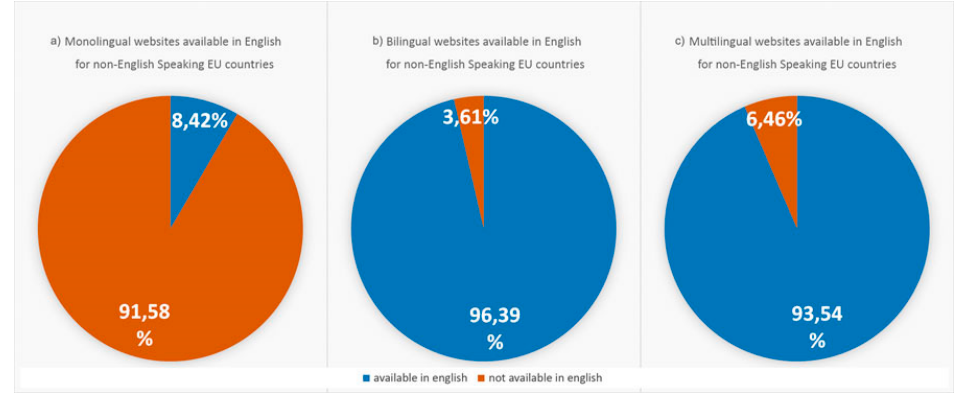
Figure 6. Percentages of Websites Available in English for non-English Speaking EU member states by number of available languages ( a ) monolingual, ( b ) bilingual, ( c ) multilingual.